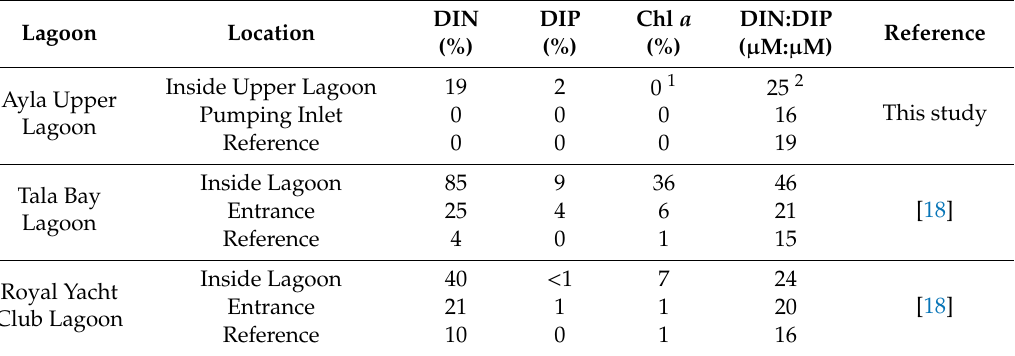
Table 1. Comparisons of the frequency of exceedance (%) oligotrophic test for DIN, DIP, and Chl a in di ff erent lagoons. Ayla’s upper lagoon (UL) is compared to other lagoons in the Gulf of Aqaba (GoA) (Tala Bay lagoon and Royal Yacht Club lagoon), according to threshold values (1.5 µ M, 0.15 µ M, and 1 µ g / L respectively) set for GoA by Badran and Zibdah